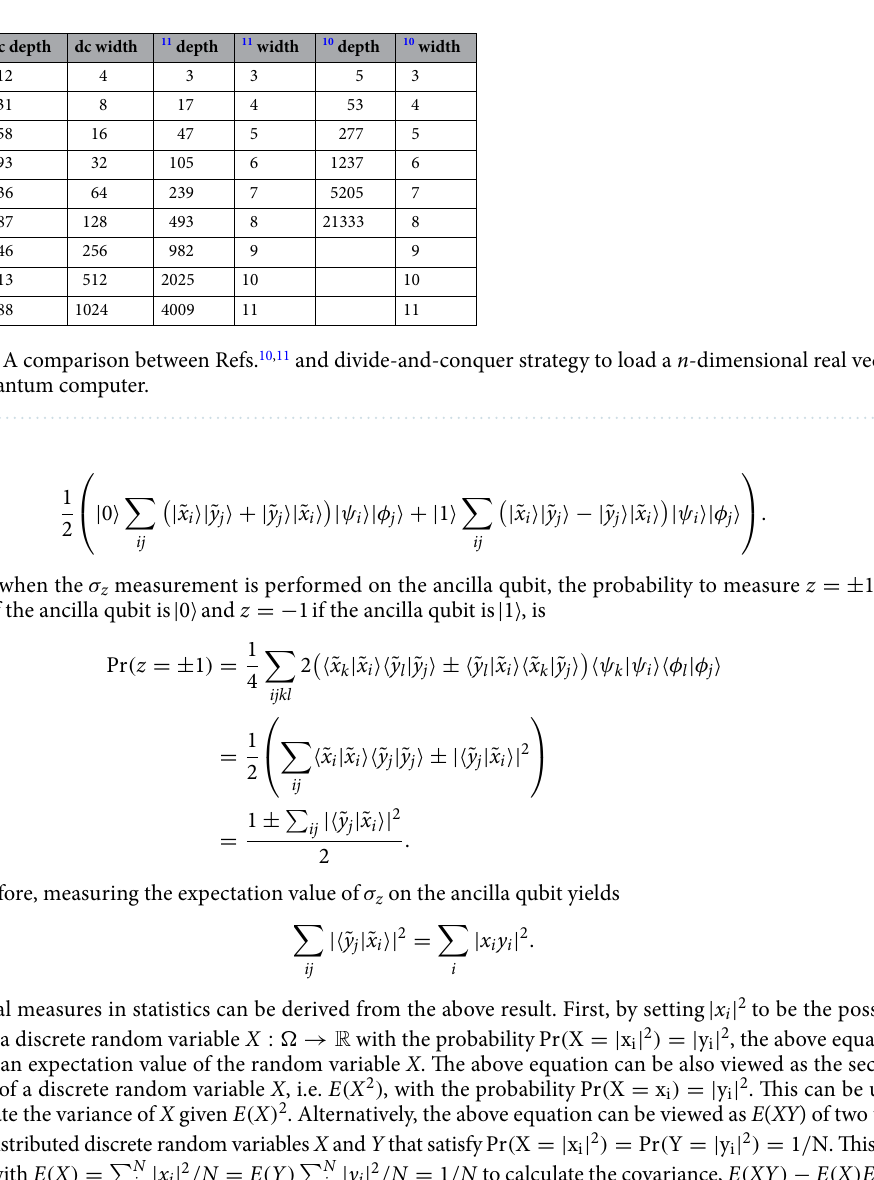
Figure 5. Proof of concept experiment with a IBM quantum device (ibmq_rome) on the cloud platform.